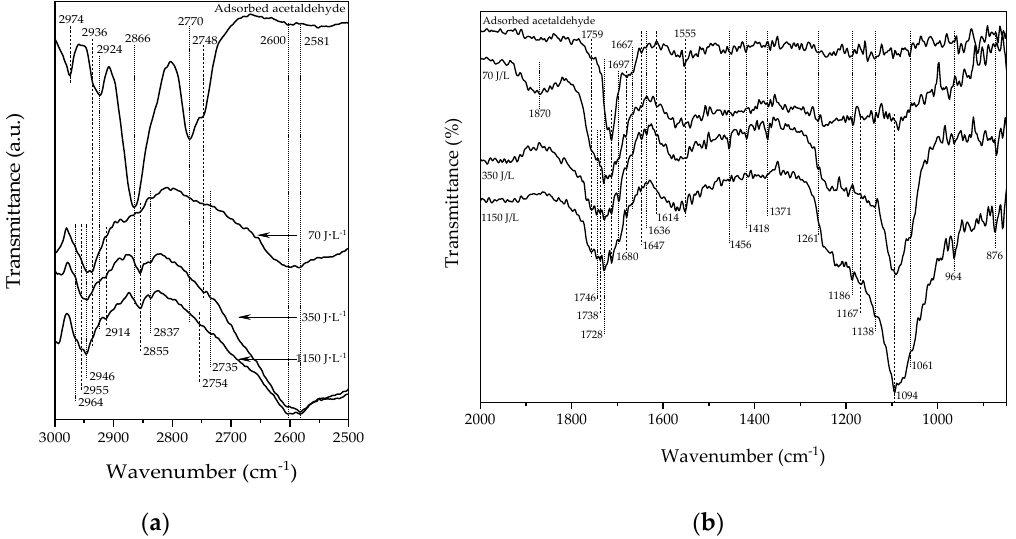
Figure 3. Ag / TiO 2 / SiO 2 catalyst surface DRIFTS spectra after saturation with CH 3 CHO; and NTP e ff ect Figure 3. Ag/TiO 2 /SiO 2 catalyst surface DRIFTS spectra after saturation with CH 3 CHO; and NTP effect on surface species at di ff erent plasma discharge energies: ( a ) C-H stretching region; ( b ) bending on surface species at different plasma discharge energies: ( a ) C-H stretching region; ( b ) bending region.